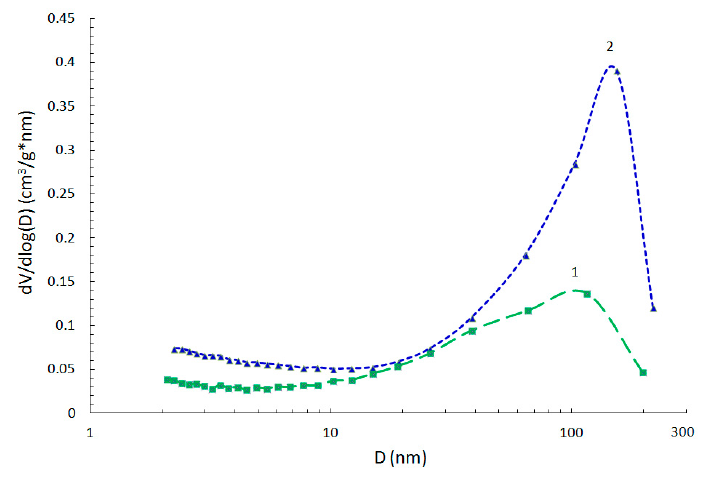
Figure 8. Pore size distribution curves for PCCNC with RGO (1) or GO (2) additives.